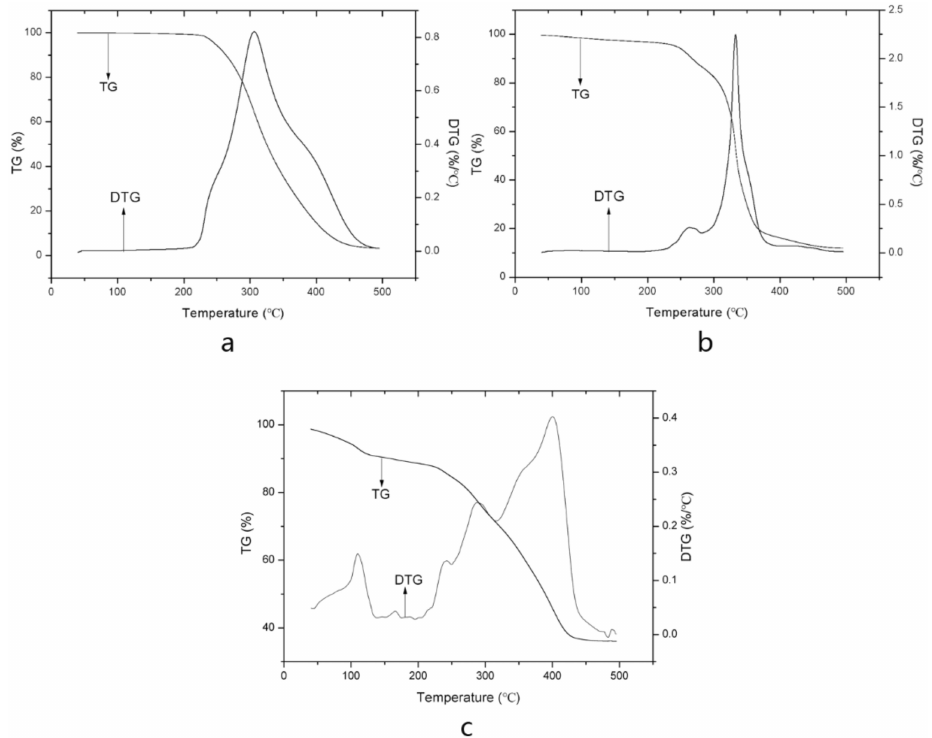
Figure 4. Thermal gravimetric analysis (TGA) curves of astaxanthin ( a ); SPC ( b ); and astaxanthin- loaded nanoliposomes ( c